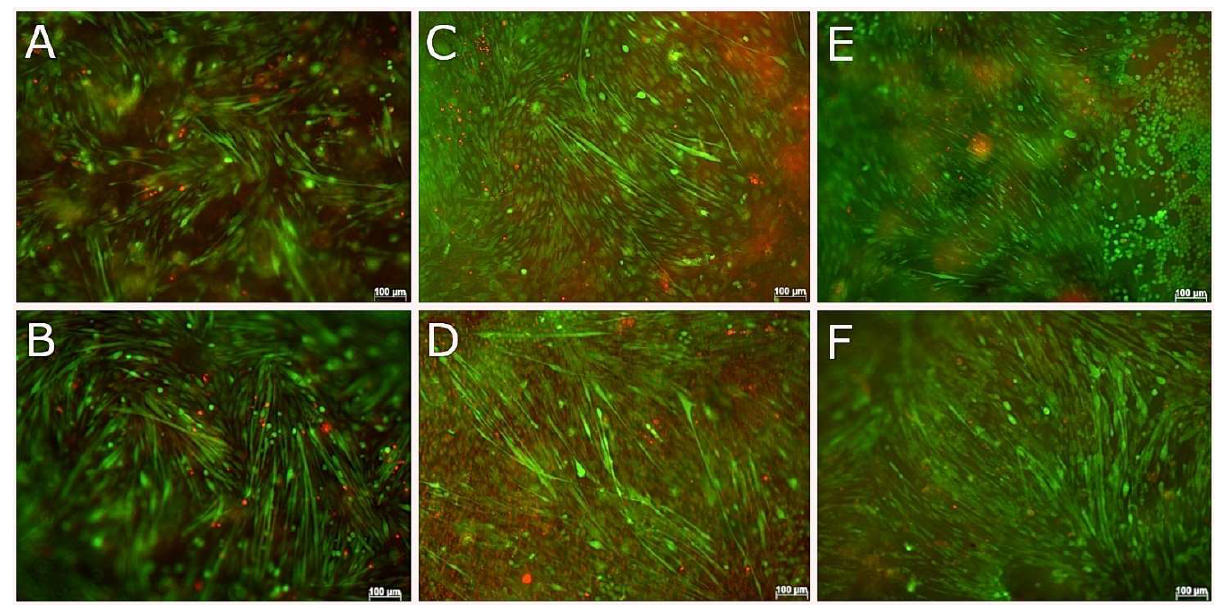
Figure 10. Live and Dead stained cells in coaxially printed scaffolds irradiated for 12 s at 12mW/cm 2 . NSC-34-laded collagen was extruded as the shell component and myoblast-laden GelMA was extruded as the core component of the bioprinted strands. Two ratios were used for extrusion, 95% core (5% GelMA)/5% shell (2.5 mg/mL methacrylated collagen) ( A , C , E ) and 90% core (5% GelMA)/10% shell (2.5 mg/mL methacrylated collagen) ( B , D , F ) at days 7 ( A , B ), 14 ( C , D ), and 21 ( E , F ). Scale bars represent 100 µm.